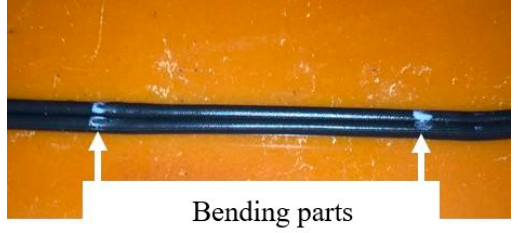
Figure 2. A typical power supply cord after bending test. Energies 2020 , 13 , x FOR PEER REVIEW